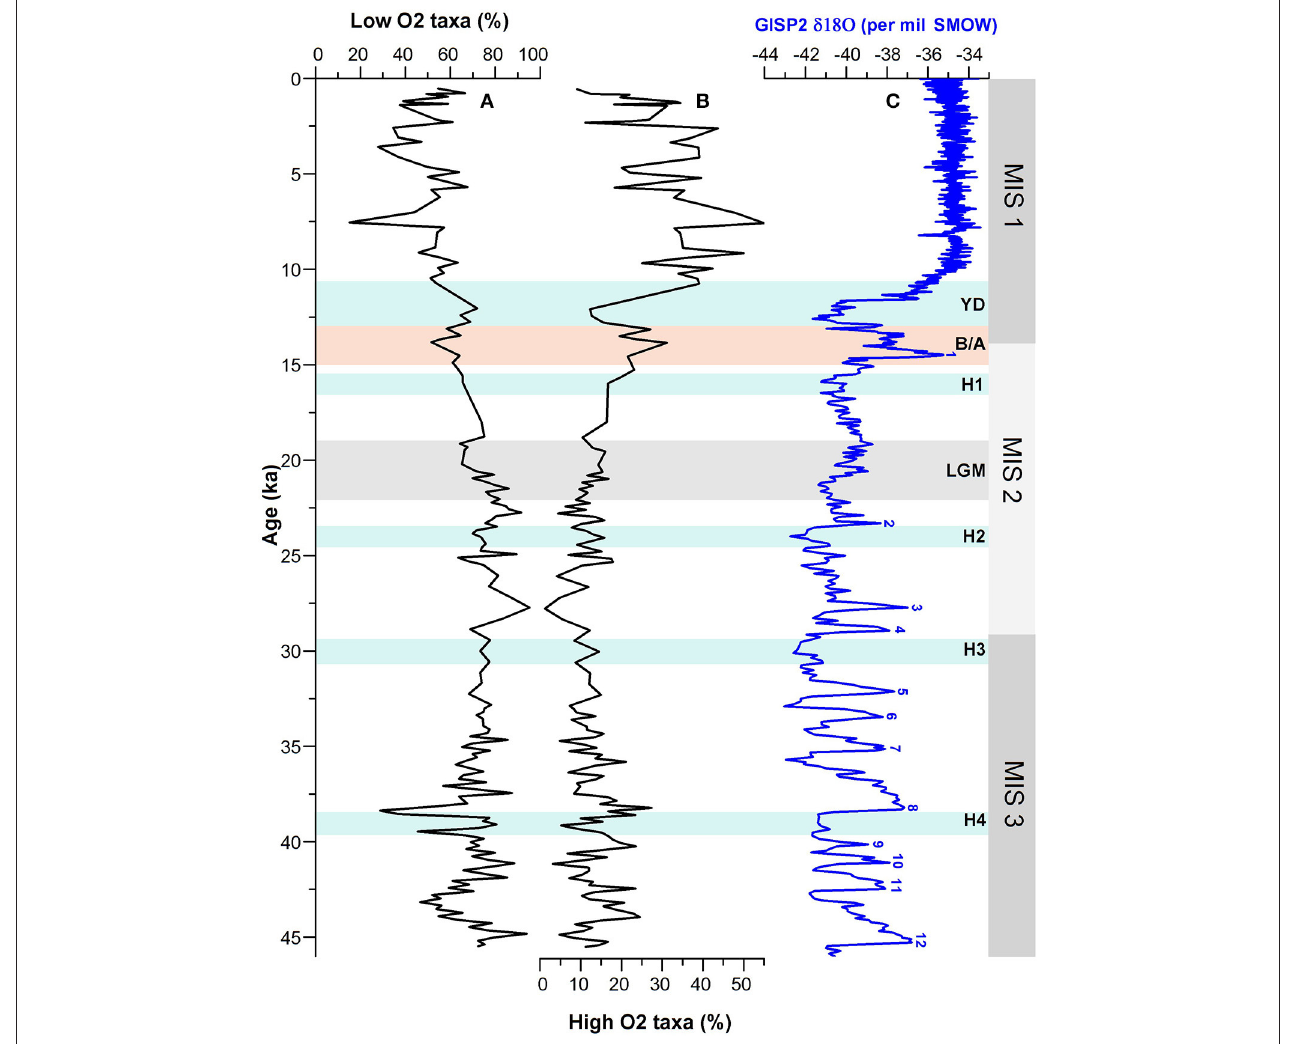
FIGURE 6 | Comparison of (A) % low-oxygen and (B) % high-oxygen taxa of benthic foraminiferal assemblages with (C) GISP2 δ 18 O ice core record. MIS 1–3 denotes the Marine Isotope Stages; H1–H4, Heinrich Events; YD, Younger Dryas; B/A, Bølling/Allerød; LGM, Last Glacial